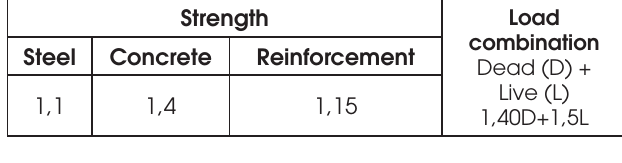
Concrete mix designs used in the study Strength Load combination Steel